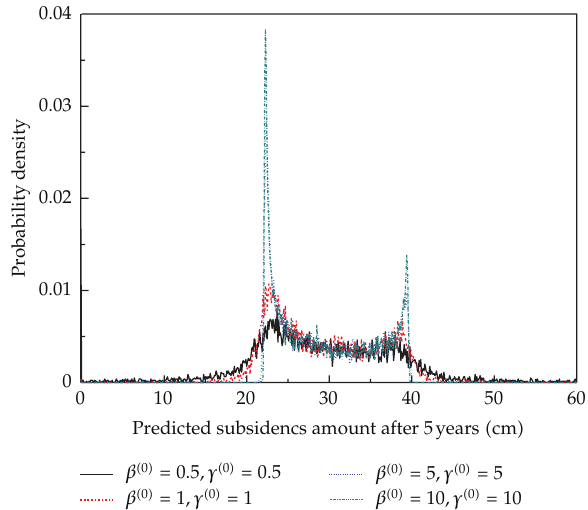
Figure 4: Distribution of predicted subsidence after 5 years.